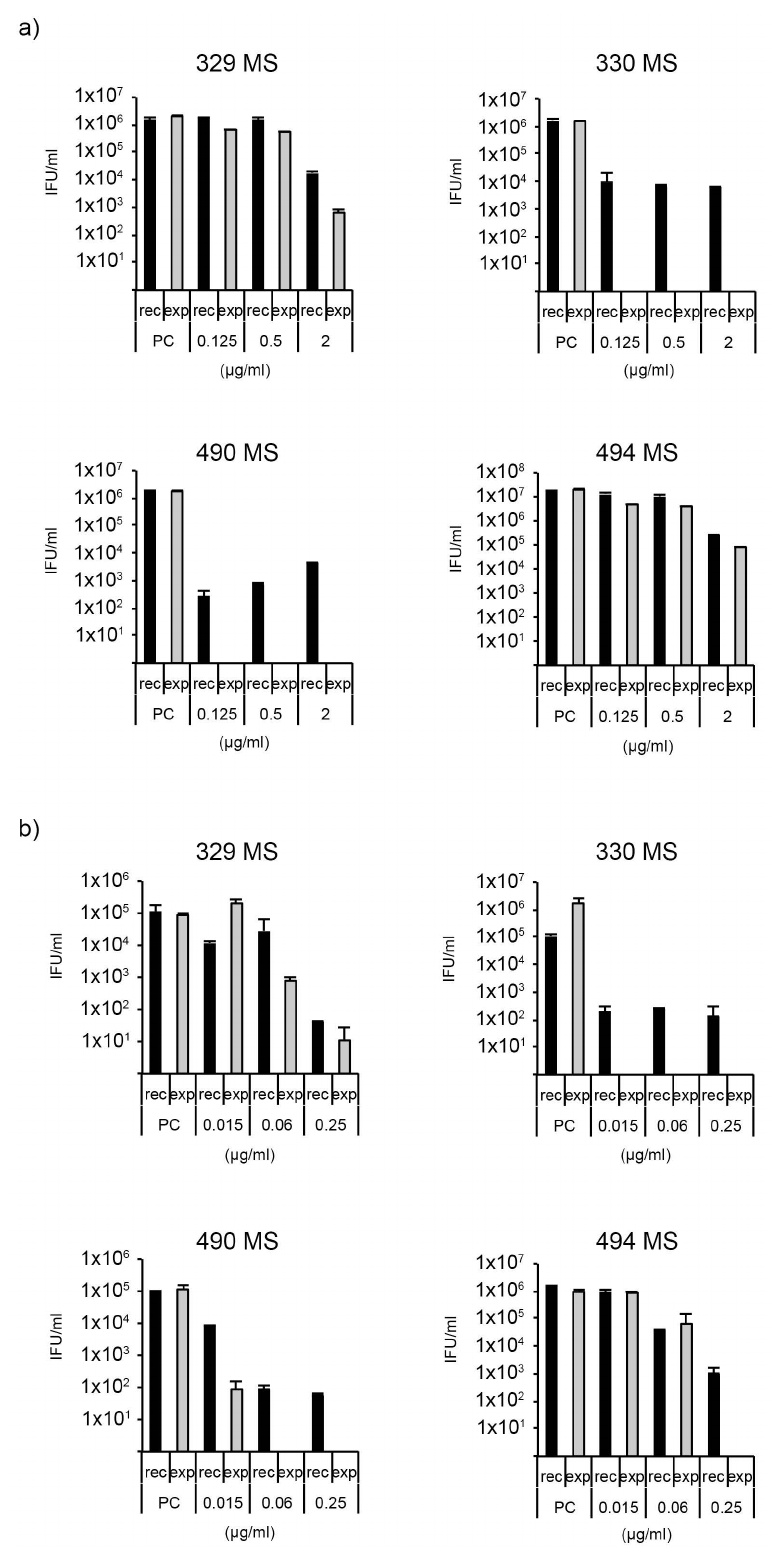
Figure 2. ( a ) Tetracycline recovery assay, and ( b ) doxycycline recovery assay according to Marti et al. [19]. X-axis: concentration of antimicrobials, y-axis: bars showing the number of viable elementary bodies EBs. Each recovery assay was performed once with two technical replicates. PC: positive control, rec: recovery group, exp: continuously exposed